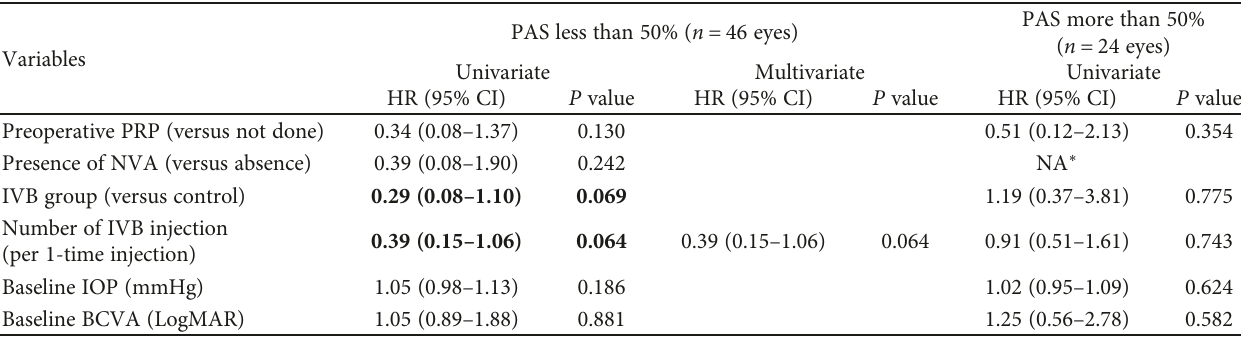
Table 5: Result of cox proportional hazard analysis for assessing risk factors of surgical failure at di ff erent stages of peripheral anterior